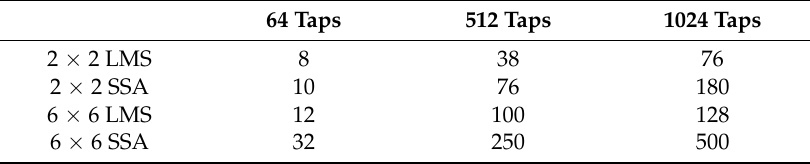
Table 2. Number of symbols required (× 10 −3 ) for convergence (approx.).